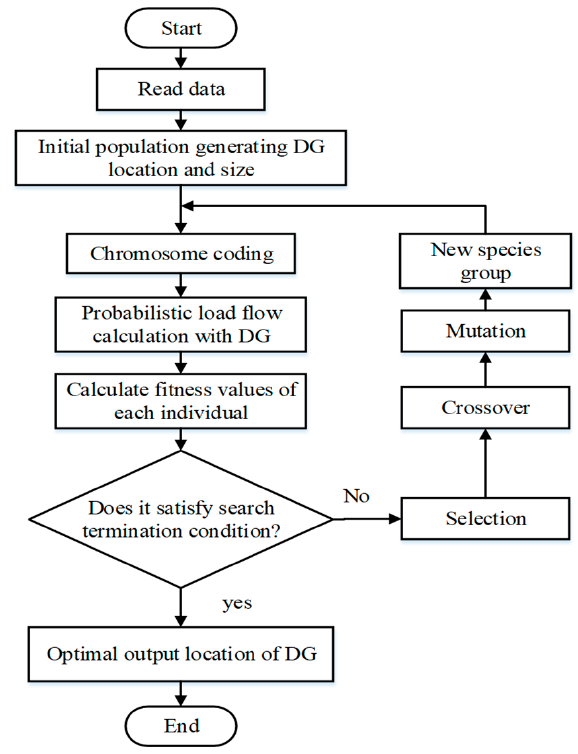
Figure 3. DG location and sizing algorithm Flow Chart.